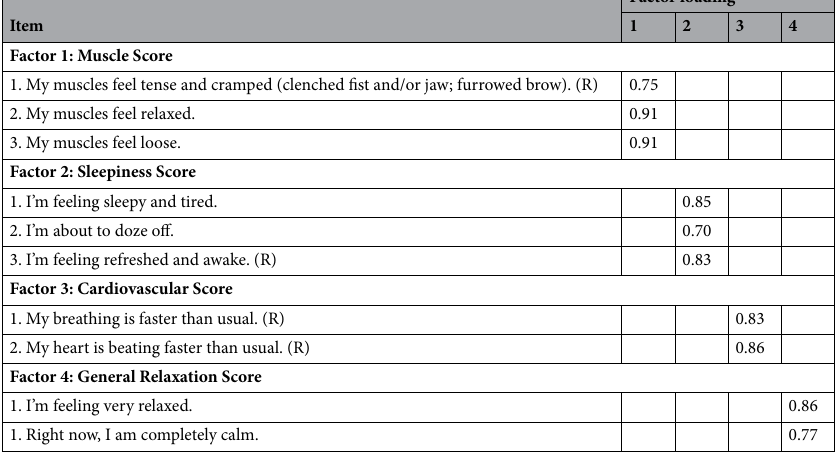
Table 7. Results from the confirmatory factor analysis. All loadings are standardized loadings. Reverse-scored items are denoted with (R).